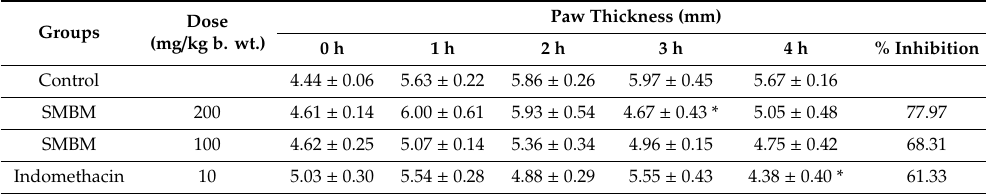
Table 4. E ff ect of SMBM against egg albumin induces paw oedema in